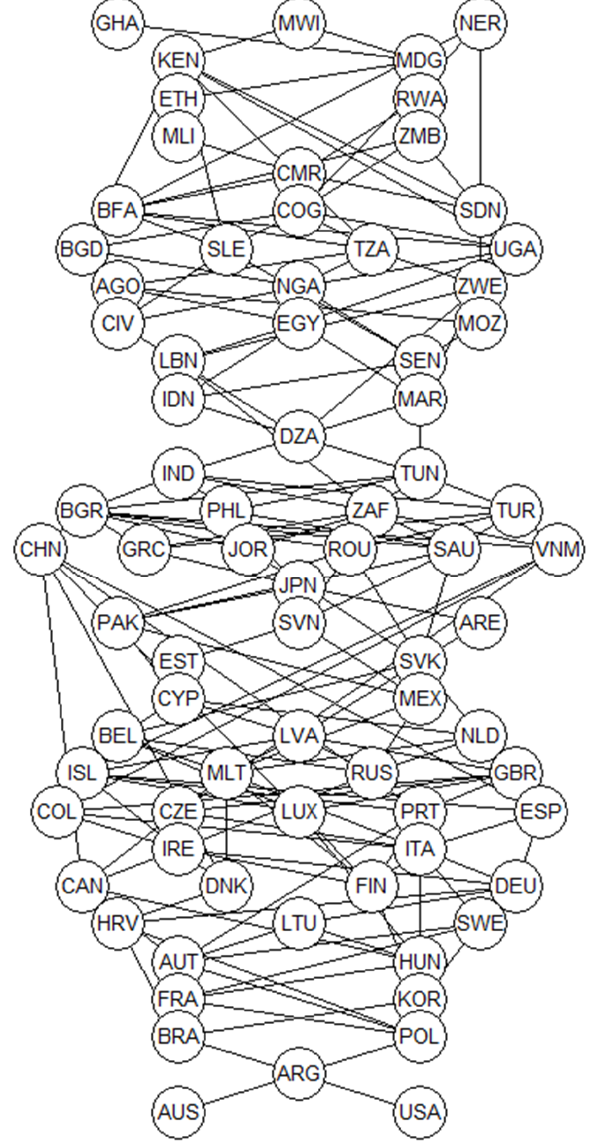
Figure 3. Hasse diagram, based on the weighting schemes of Table 12 and the data obtained by GLA and shown in Table and shown in Table 13.